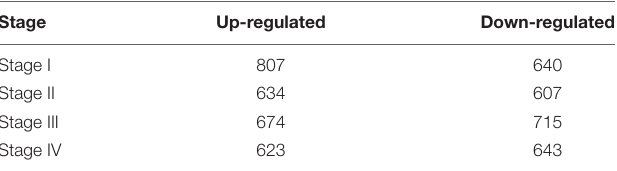
TABLE 4 | Up-regulated and down-regulated genes in stages I, II, III, and IV associated with colon and rectal cancer in GSE21510 dataset.